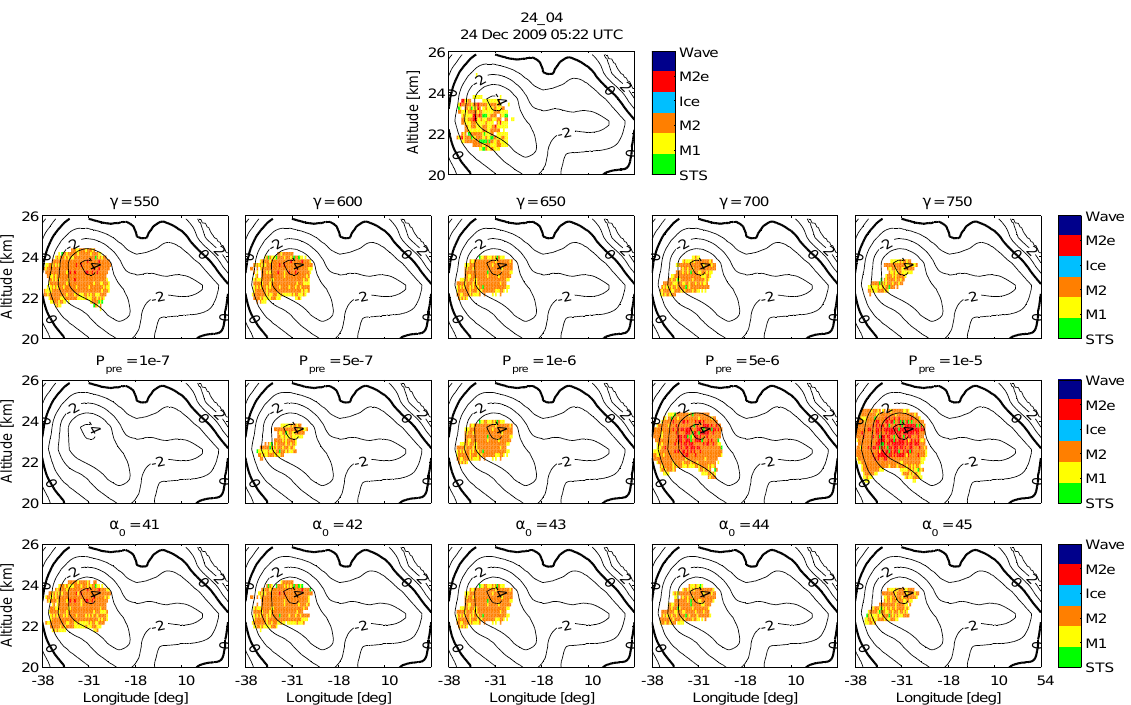
Fig. 6. An illustration of the sensitivity of the modelled NAT classification (the different classifications are indicated by the colours in the plot) to the three fitting parameters used in the new model, applied to CALIPSO orbit 24-12-2009 05:22:08UTC (denoted orbit 24_04 in the text). The uppermost panel shows the observed PSC, and the contour lines show the temperatures with respect to T NAT (from the ERA-Interim reanalysis) at the time of CALIOP observation. The top row of panels shows how the results change as γ 0 is varied, while P pre is held constant at 1 × 10 − 6 deg − 1 , and α 0 at 43 ◦ . In the second row, P pre is varied while γ 0 is held constant at 650K 3 , and α 0 at 43 ◦ , while in the bottom row P pre and γ 0 are held constant at 1 × 10 − 6 deg − 1 and 650K 3 respectively, while α 0 is varied. T NAT and below T NAT – 4K, while the contour lines on these two rows of plots show the minimum temperature reached along the trajectory, with respect to T NAT